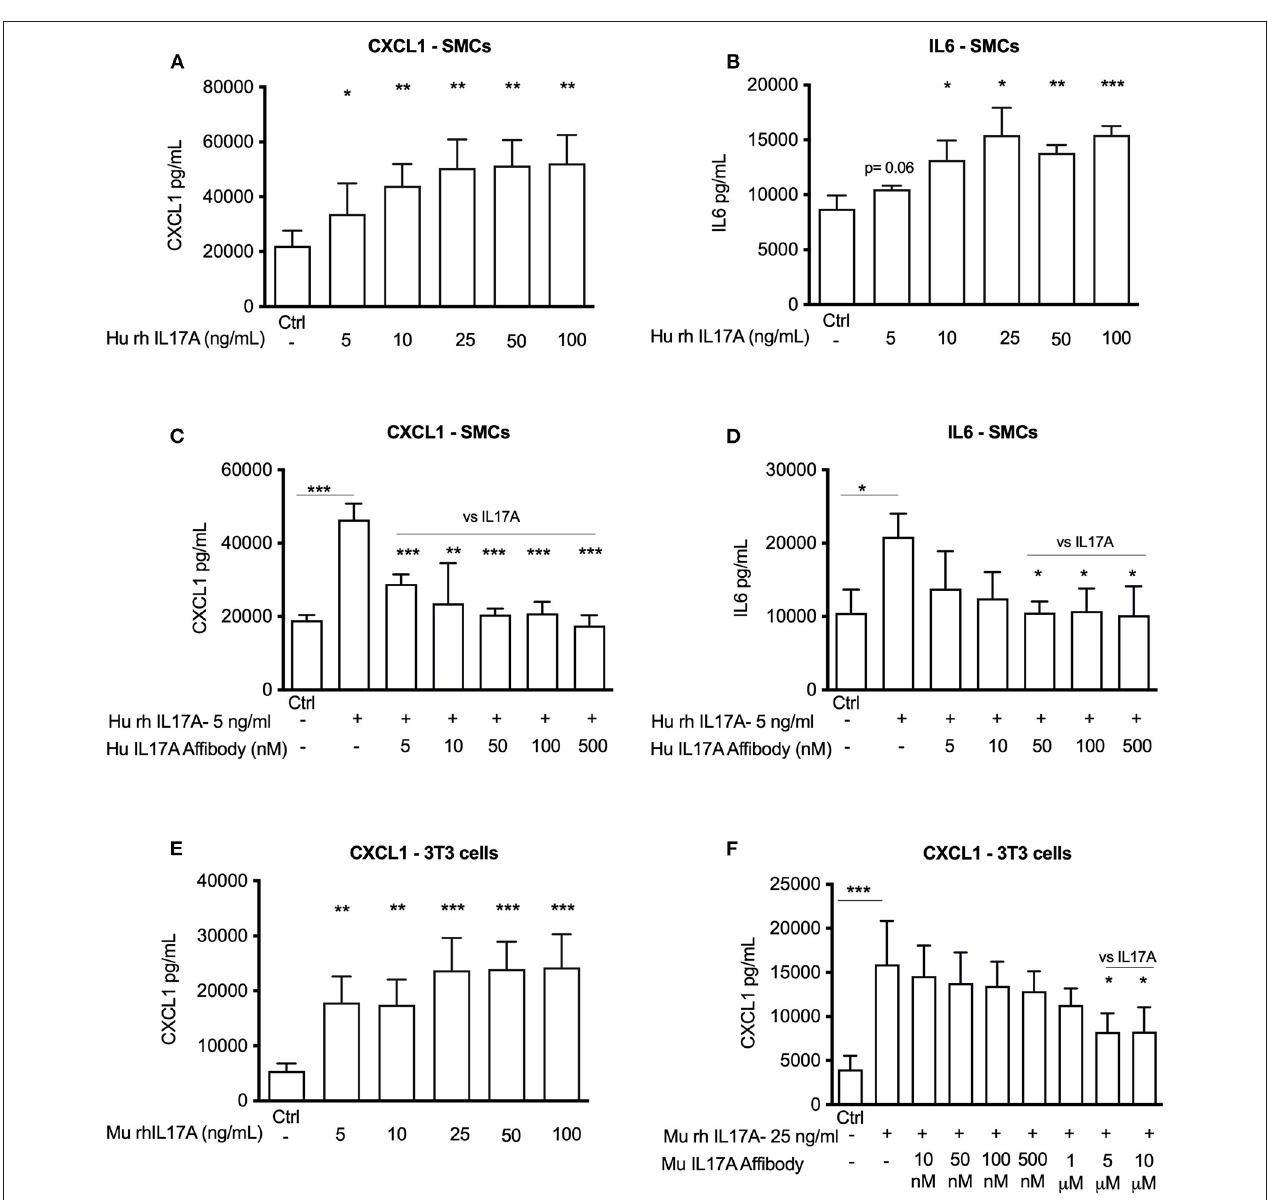
FIGURE 1 | In vitro efficacy of Affibody molecules in blocking IL17A induced responses in human aortic smooth muscle cells (SMCs) and mouse NIH/3T3 fibroblast cells. ELISA data showing the release of CXCL1 and IL6 into the medium (24h) induced by increasing concentration of recombinant IL17A in human SMCs ( n = 4) (A,B) and CXCL1 in mouse 3T3 fibroblast cells ( n = 4) (E) . Human SMCs were stimulated with 5ng/ml recombinant IL17A and without or with increasing concentrations of human Affibody molecules against IL17A and release of CXCL1 and IL6 (24h) was assessed by ELISA ( n = 3) (C,D) . Mouse NIH/3T3 fibroblast cells were stimulated with 25ng/ml recombinant IL17A and without or with increasing concentration of Affibody molecule against mouse IL17A and release of CXCL1 (24h) was assessed by ELISA ( n = 5) (F) . Data is presented as mean ± SD. * p < 0.05 , ** p < 0.01, *** p < 0.001 vs. control or as mentioned in graph (vs. IL17A).